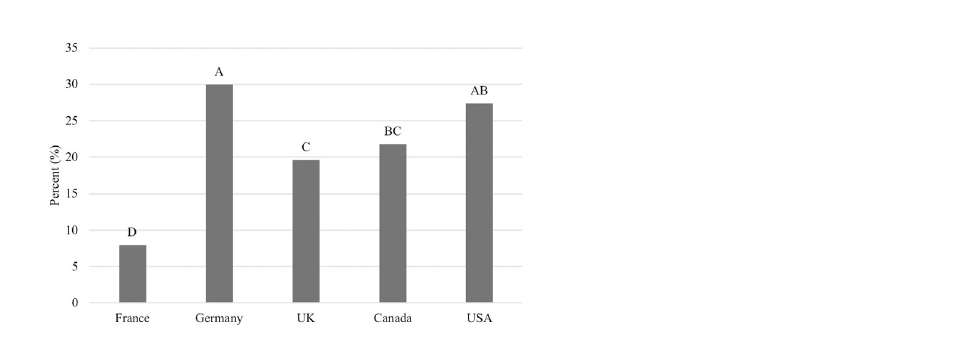
Fig 7. Percent of respondents in each country that look for “no grain” when selecting a pet food (n = 3,298). Proportions that do not share a common letter are significantly different at P < 0.05.